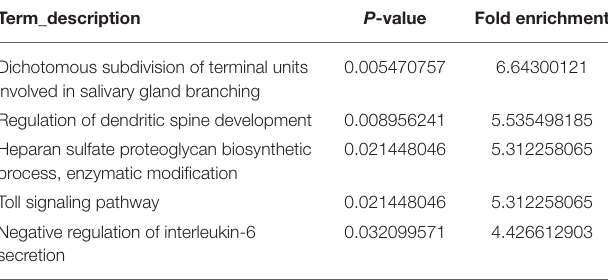
TABLE 4 | Chip results pathway enrichment